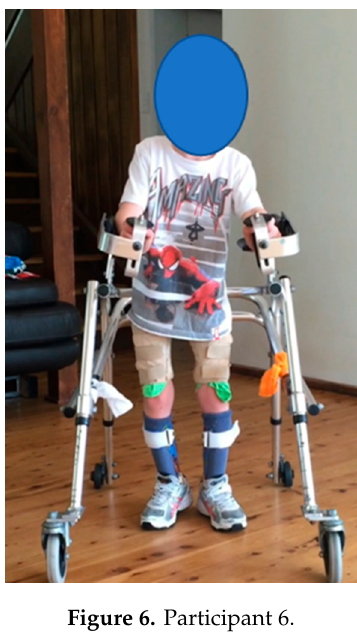
Table 7. Participant 6 outcome measures comparative results between SMotO and AFO.